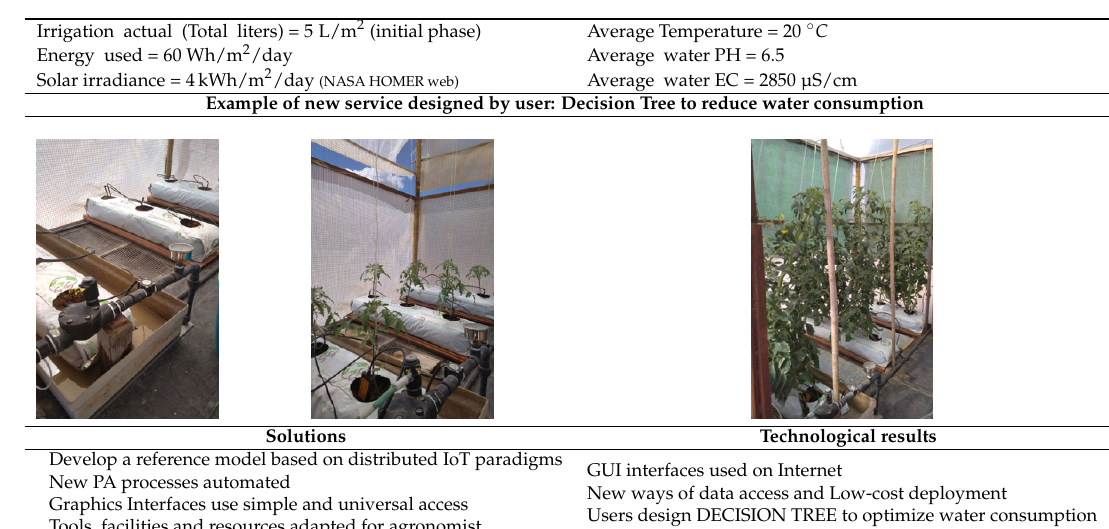
Table 4. Growth crop process on experimental station. Tomato plant growth